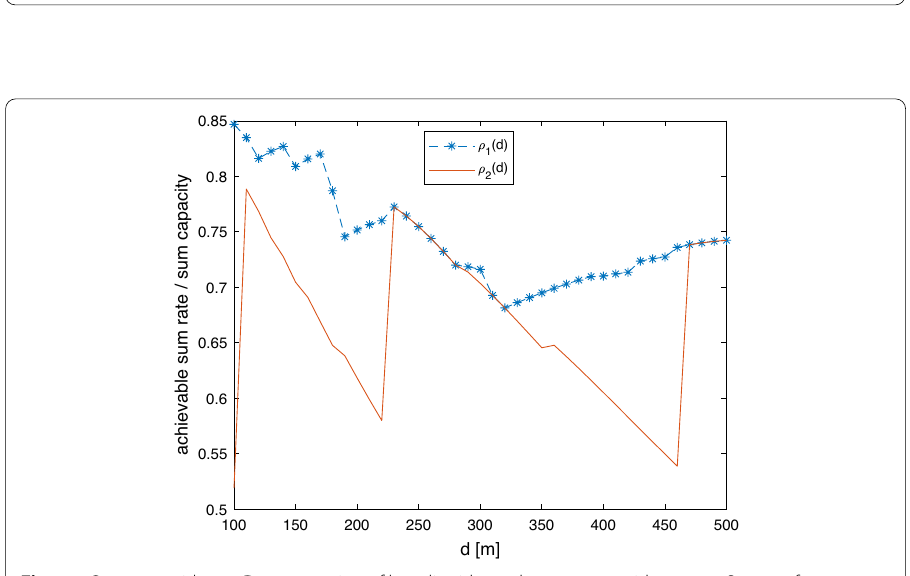
Fig. 14 Gap to capacity. The plot shows the ratio of achievable rate to capacity for different channel coefficients (i.e., due to a change in the geometry of the setup in Fig. 7). From top to bottom, the curves represent the maximum, average, and minimum performance for all states in S ′ d of the liquid metal antenna of Fig. 8